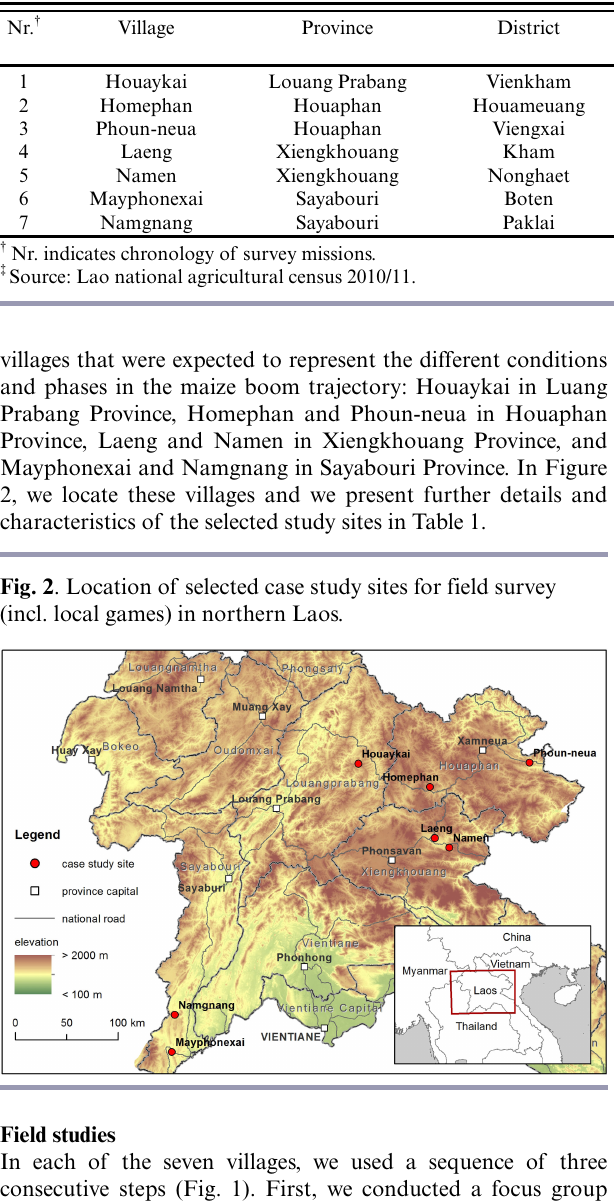
Table 1 . Characteristics of selected villages.